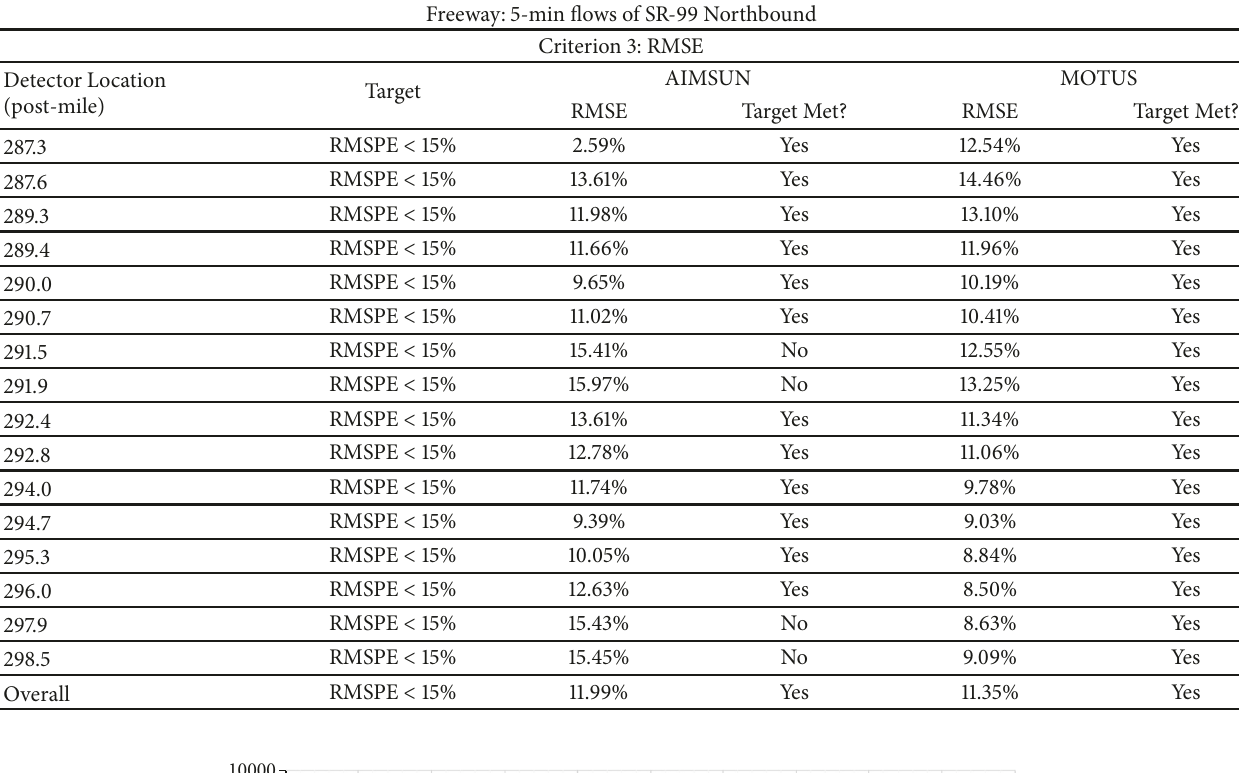
Table 5: Calibration of freeway flows under RMSE criterion.